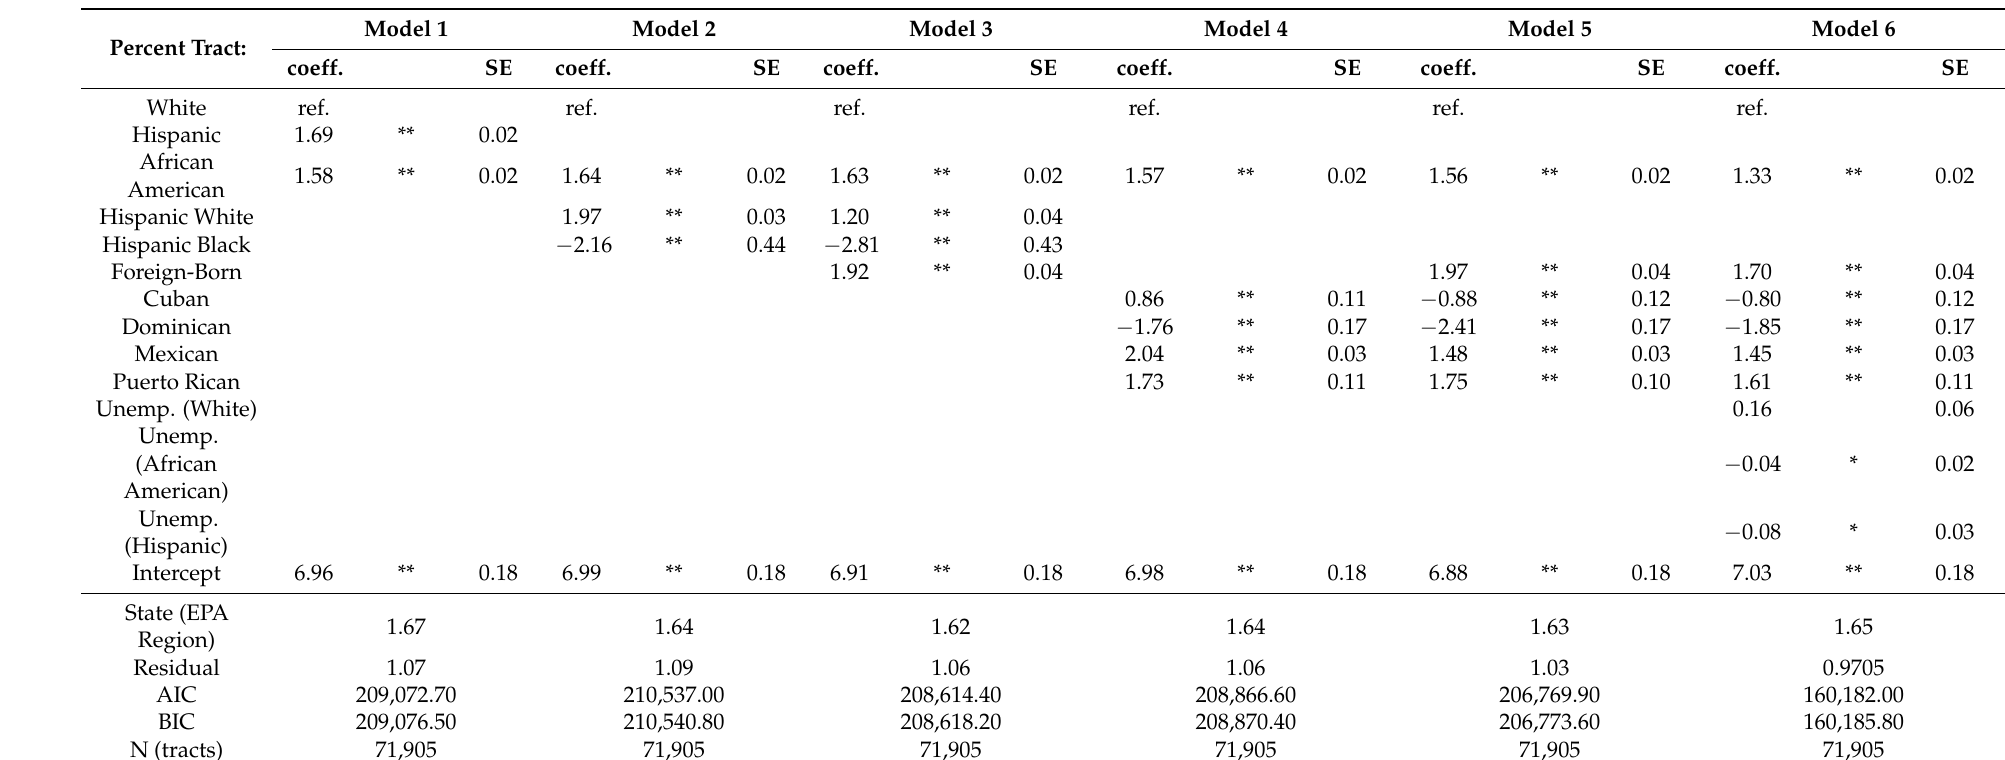
Table 5. Results from the linear mixed model predicting tract level PM 2.5